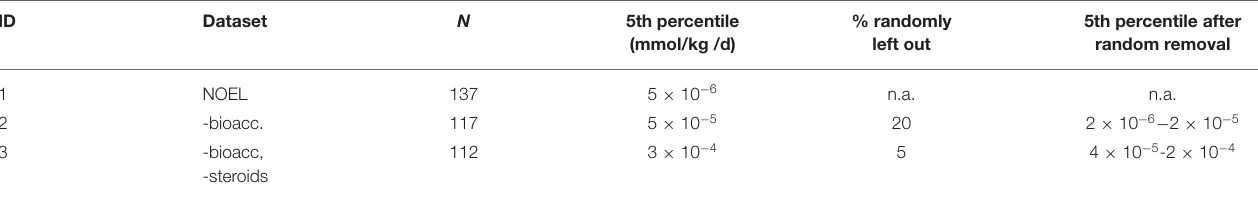
TABLE 1 | Impact of two different compound classes on the fifth percentiles in the NOEL dataset; ID 1- all NOEL values ( N = 137 cmpds); exclusion of bioaccumulating compounds (ID 2; N = 117; reduction by 20%) and subsequently steroid-like compounds ( N = 112; additional reduction by 5%).